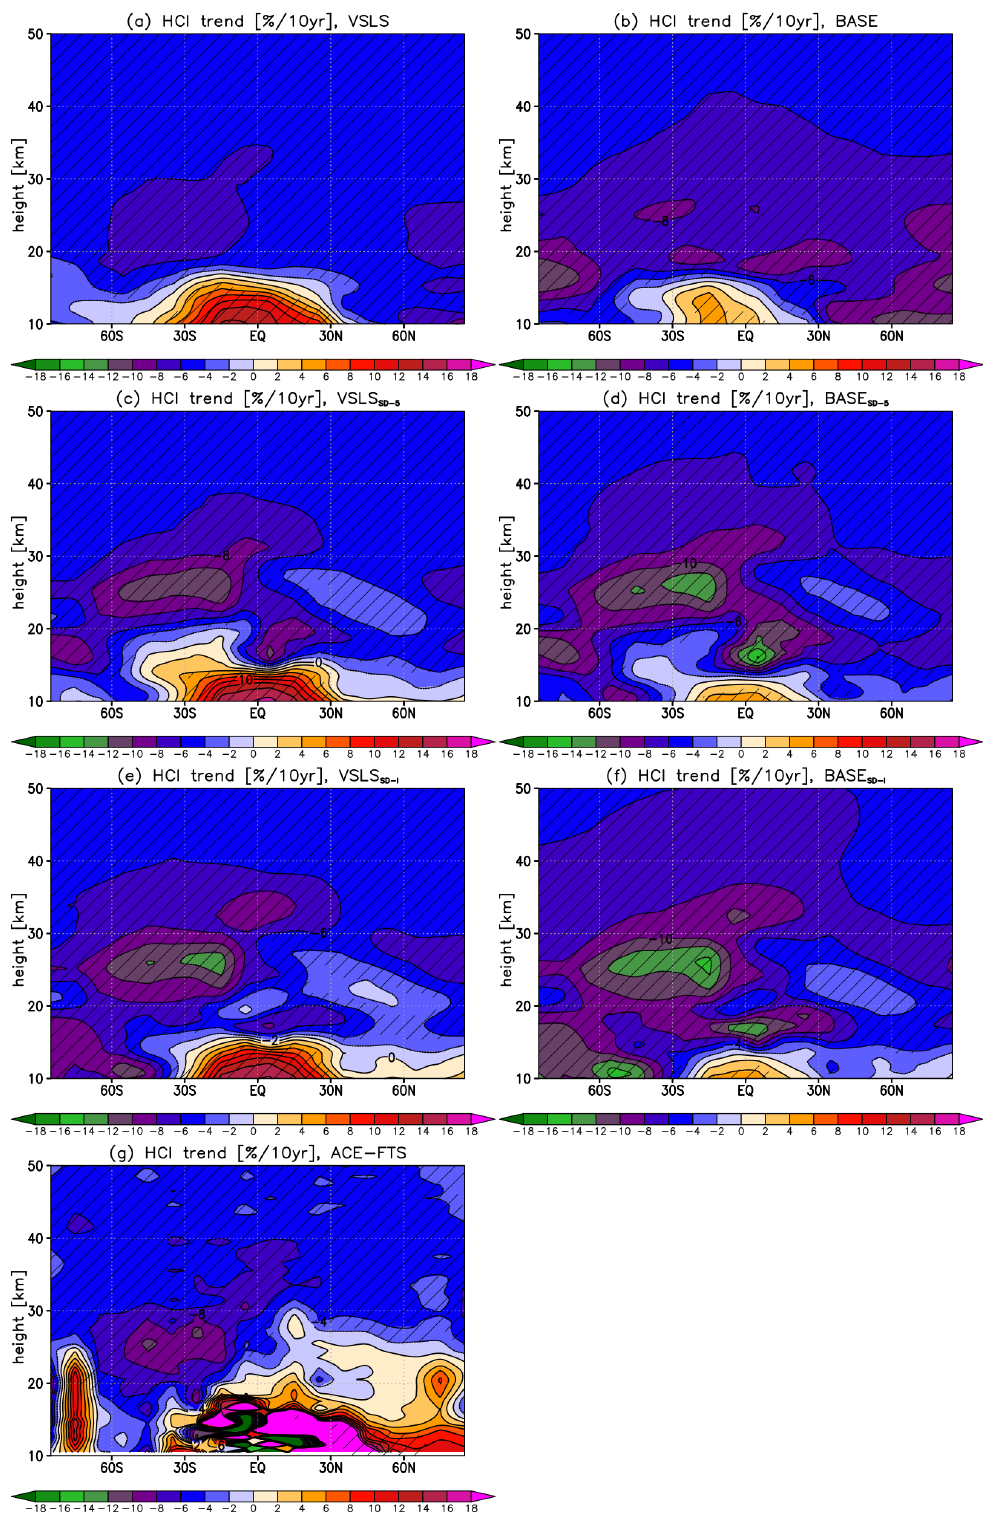
Figure 8. Linear trends in deseasonalised HCl mixing ratios [% per 10 years] in (a) the ensemble mean VSLS, (b) ensemble mean BASE, (c) the nudged VSLS SD-5 , (d) BASE SD-5 , (e) VSLS SD-I , (f) BASE SD-I , and from (g) the observed ACE-FTS satellite data (g) . Trends in (a, b, c, d, g) are calculated over MAM2004–SON2019; trends in (e, f) are calculated over MAM2004–JJA2019. Hatching indicates statistical significance, here taken as regions where the magnitude of the derived trend exceeds ± 2 standard errors.